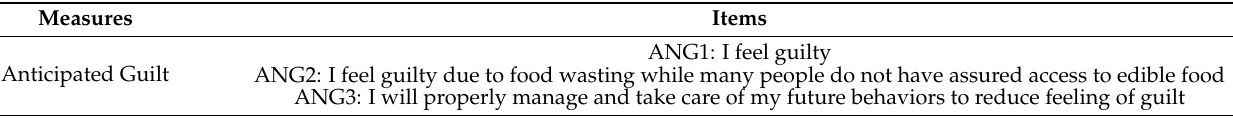
Table A1. Items of each